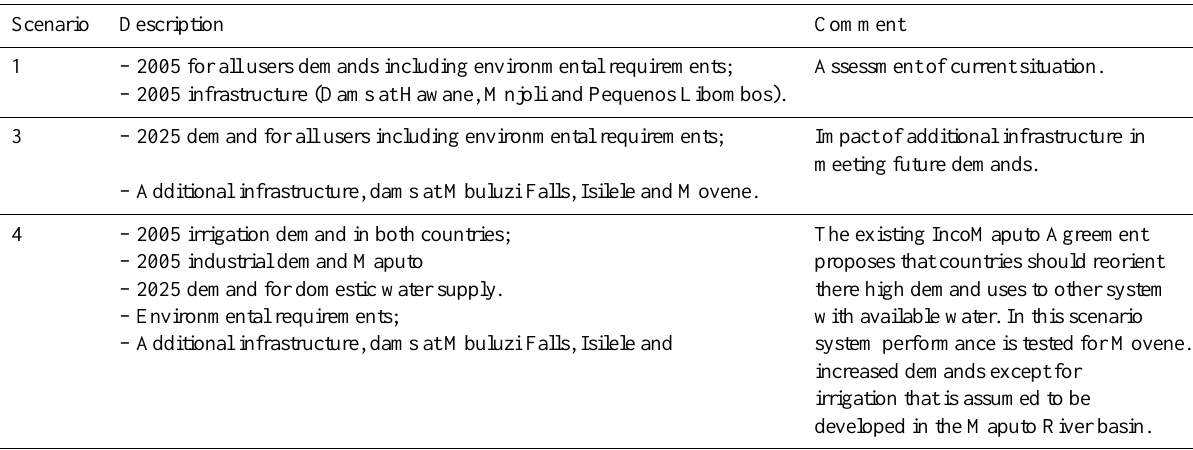
Table 6. Scenario development for Umbeluzi River basin.